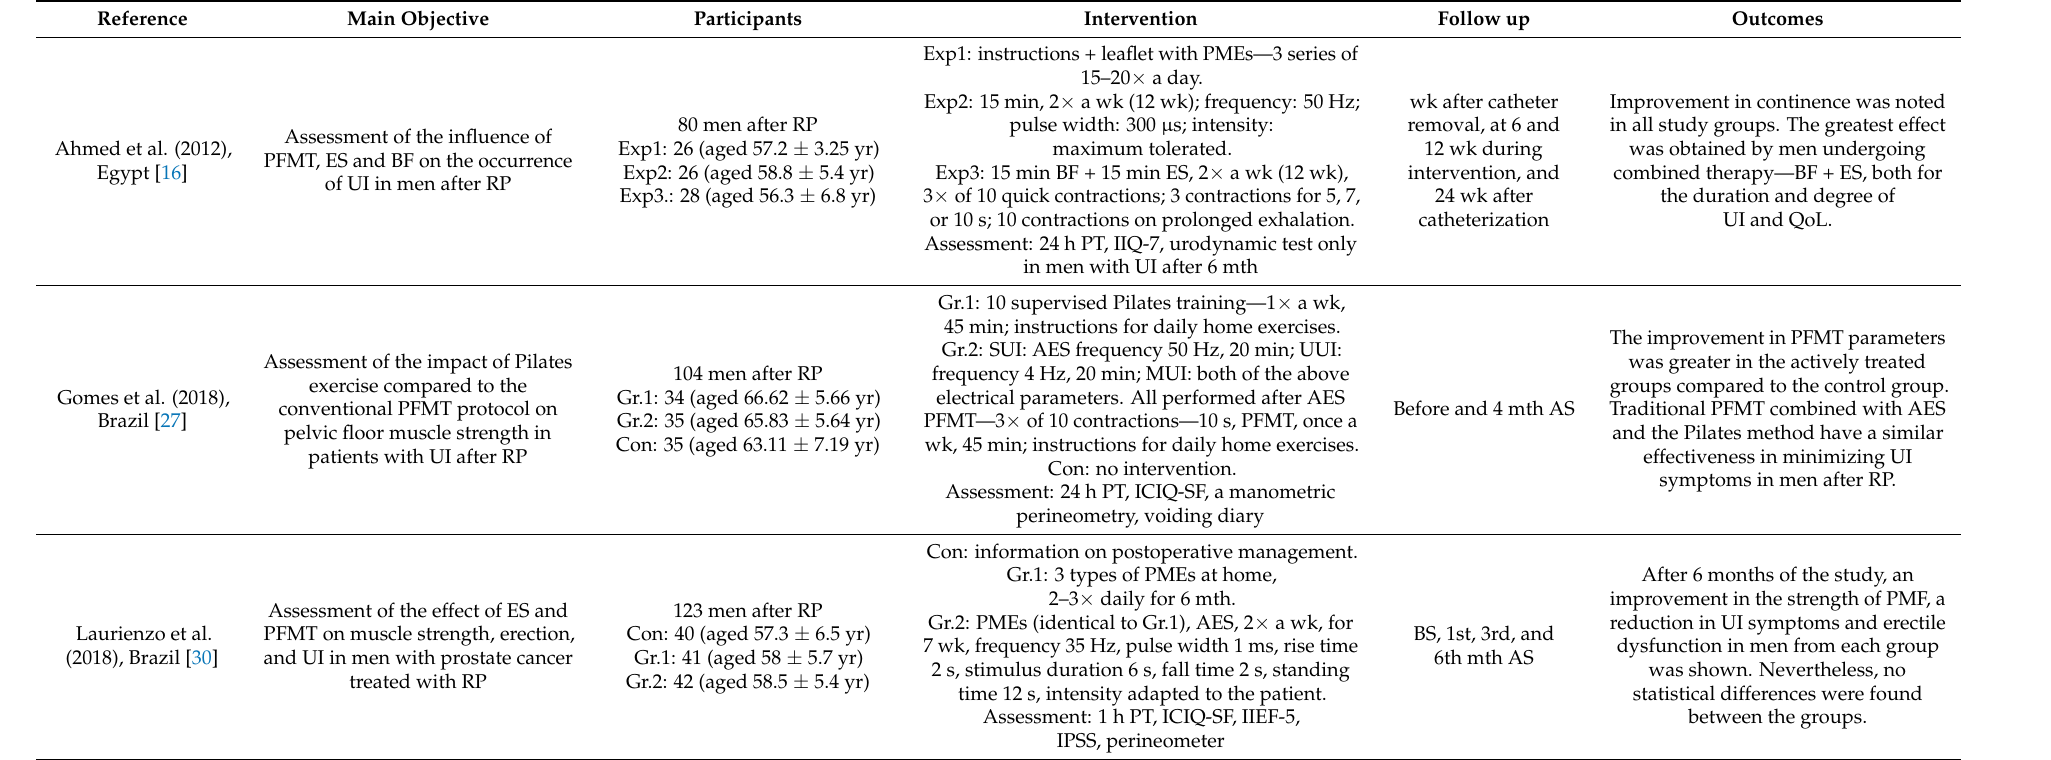
Table 4. Electrostimulation in men with UI after